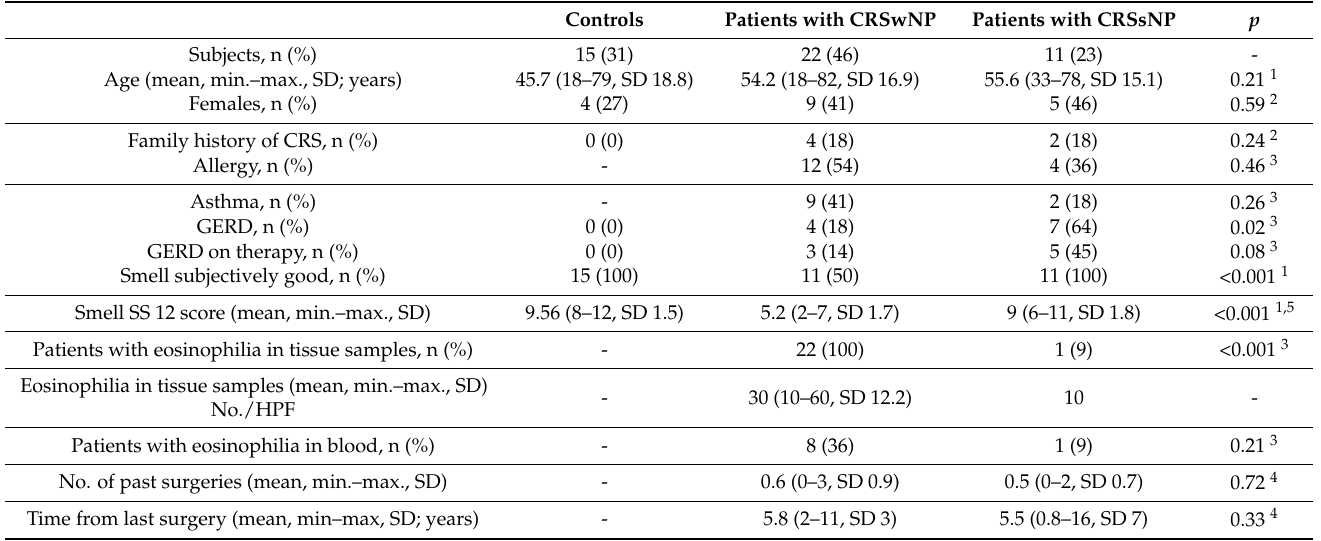
Table 1. Patients’